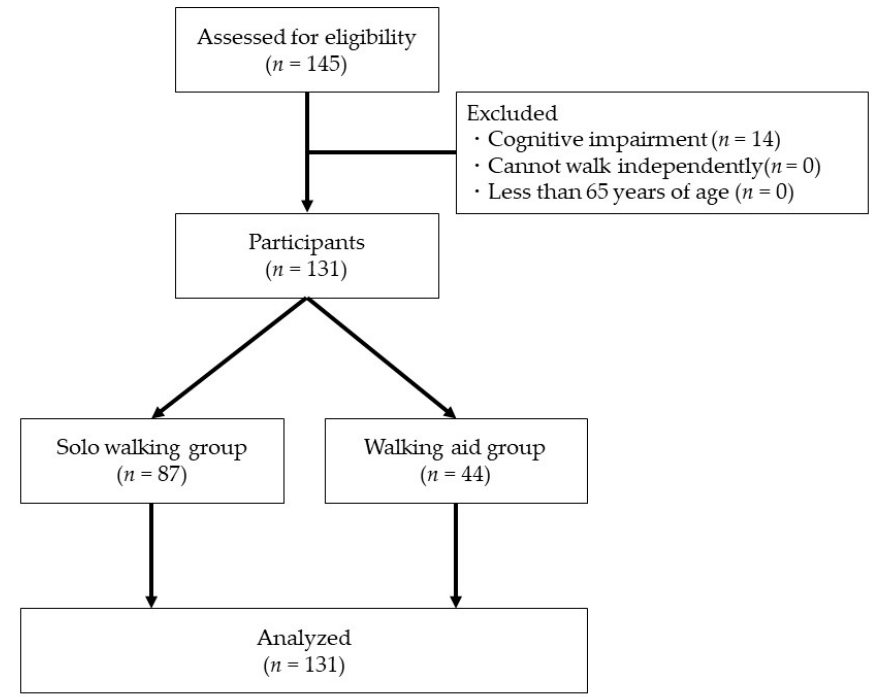
Figure 1. Participant selection flowchart.